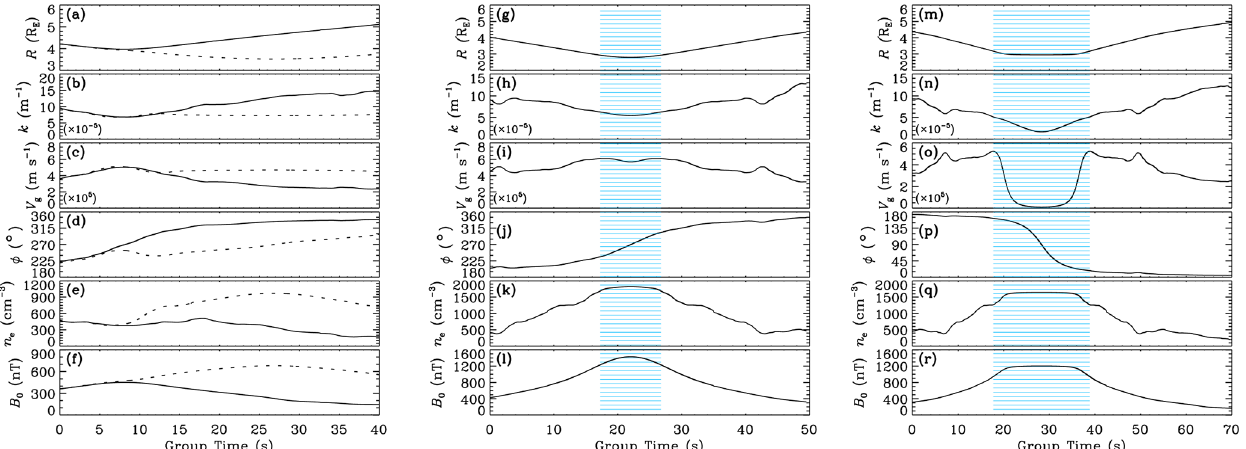
Figure 5. The time series of (a, g, m) radial distance R , (b, h, n) wavenumber k , (c, i, o) group velocity V g , (d, j, p) local azimuthal angle φ , (e, k, q) electron number density n e and (f, l, r) ambient magnetic field B 0 for the selected rays. The blue shaded areas in (g–l) and (m–r) represent the regions of velocity